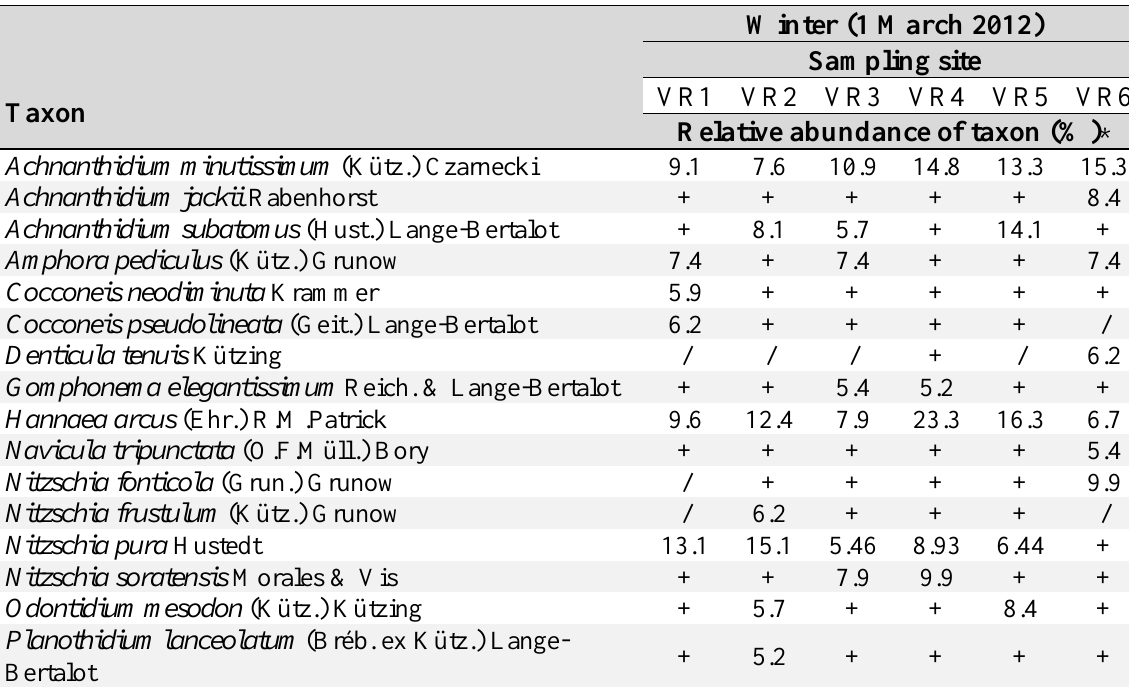
Table 4. Relative abundance of diatom taxa (%) present in the epilithic diatom community in the Vrla River during the winter period (1 March